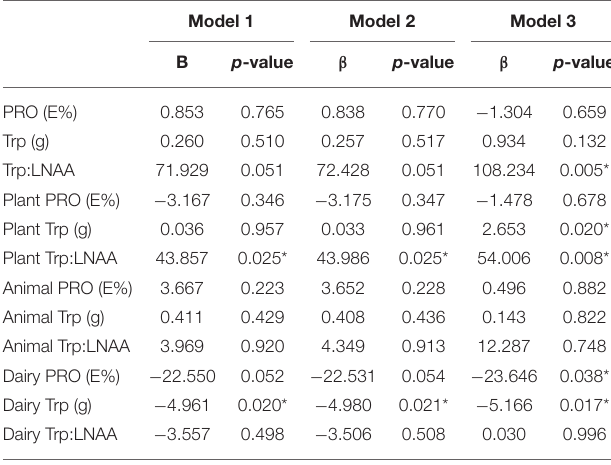
TABLE 4 | Association between sleep duration with dietary protein